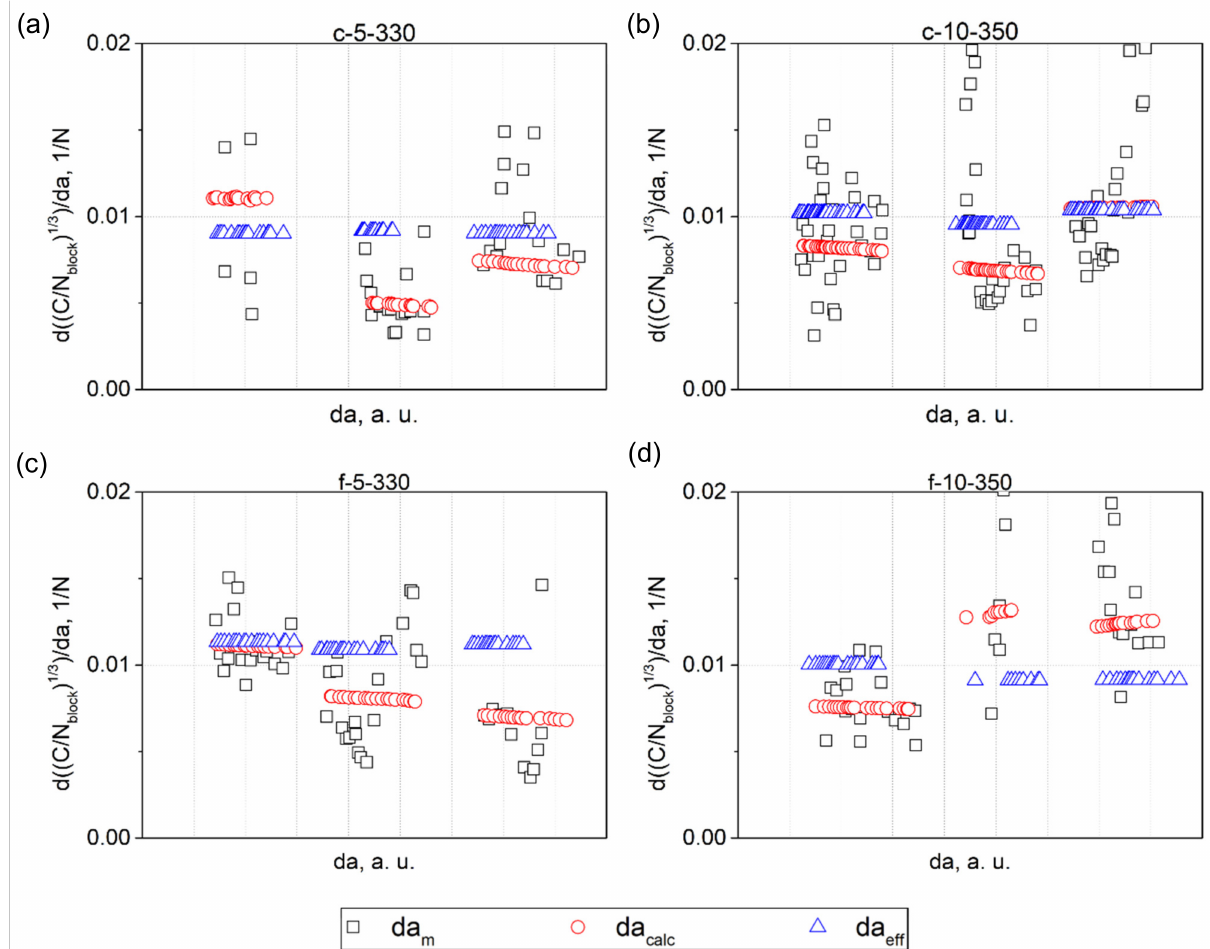
Figure 9. The values of the slopes of linear regressions fitted to datasets of five consecutive points for: ( a ) c-5-330; ( b ) c-10-350; ( c ) f-5-330; and ( d ) f-10-350. 01-03 numbers refer to serial numbers of the specimens. The legend applies to every